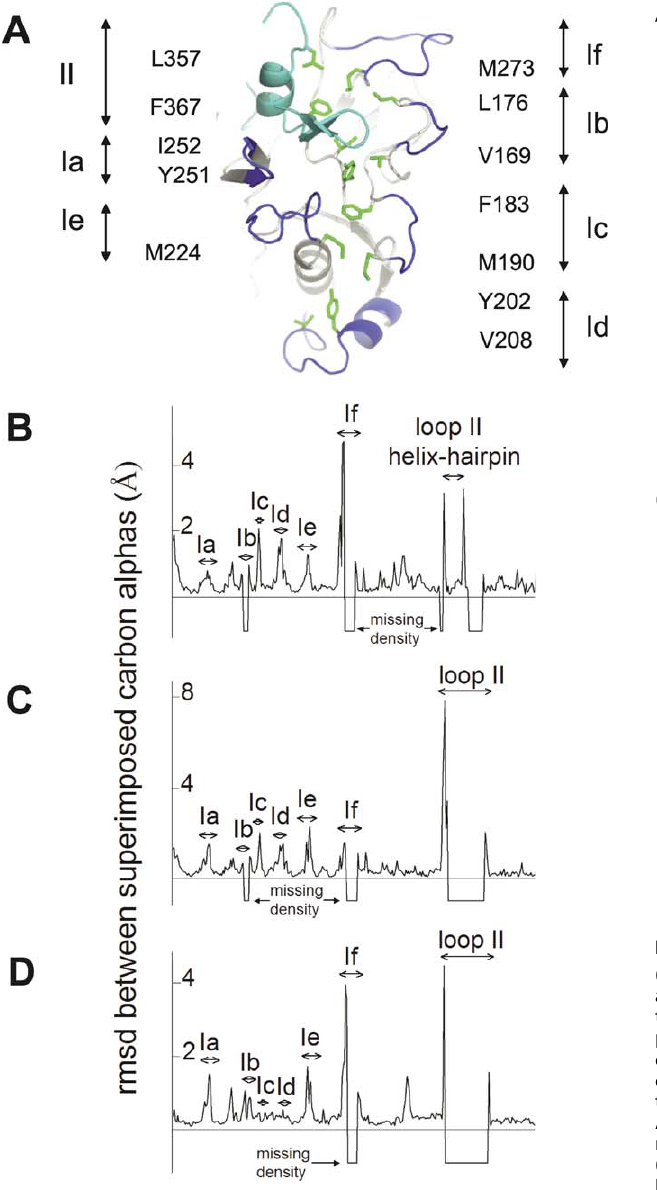
Figure 5. Comparison of Free and 1F9-Complexed AMA1 Structures (A) Structure of the hydrophobic trough and surrounding loops. Domain I loops, Ia-If, are shown in dark blue. The domain II loop, II, is shown in light blue. The 12 hydrophobic trough residues are shown in green with the label on either side of the figure showing the amino acid and numbering. I252 and Y251 are not adjacent to loop Ia, but other trough residue labels are shown next to the loop they are associated with. (B–D) Comparison of the main-chain trajectories of AMA1 structur- es.rmsds between superimposed carbon alphas were calculated using the program LSQKAB [54] and plotted for each residue. (A) Comparison between AMA1 model 1Z40 and AMA1-1F9 crystal form 1. (B) Comparison between AMA1 model 1Z40 and AMA1-1F9 crystal form 2. (C) Comparison between AMA1-1F9 crystal forms 1 and 2. In instances where residues were missing in either of the compared models the rmsd was assigned a value of (cid:2) 1.